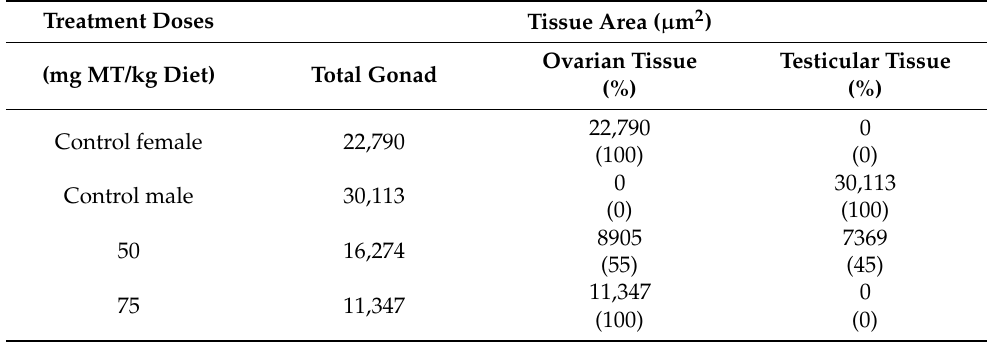
Figure 8. Sagittal sections through the gonad of the MG female treated with the 50 mg MT/kg diet. (A) Testicular tissue (inset framed by black broken rectangle) located next to an embryo (E) observed inside the ovarian sac of the treated female. (B) The testicular tissue at higher magnification showed various stages of spermatogenesis such as primary spermatocytes (S1), secondary spermatocytes (S2), early (S3) and late (S4) spermatids as well as spermatozoa in spermatozeugmata (SP). Anterior to left and posterior to right. Table 2. Total gonad and testicular tissue areas of MG females treated with MT for a 50-day period ( n = 1